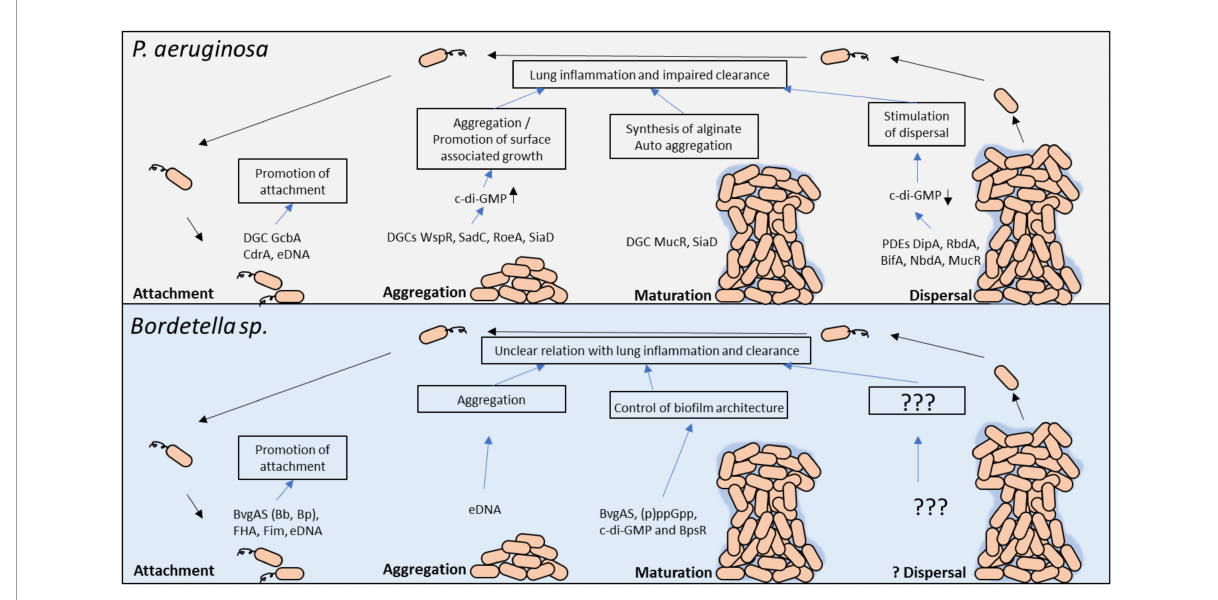
FIGURE2 Molecular regulators in P. aeruginosa and Bordetella spp. biofilm development and their potential role in persistent lung infection. Each stage of biofilm development and the main molecular modulators are shown. The gray box above highlights the key factors involved in P. aeruginosa biofilm formation, whereas the light blue box below highlights the known factors in Bordetella spp. biofilm regulation. c-di-GMP, cyclic dimeric guanosine monophosphate; PDE, phosphodiesterase; DGC, diguanylate cyclase; eDNA, extracellular